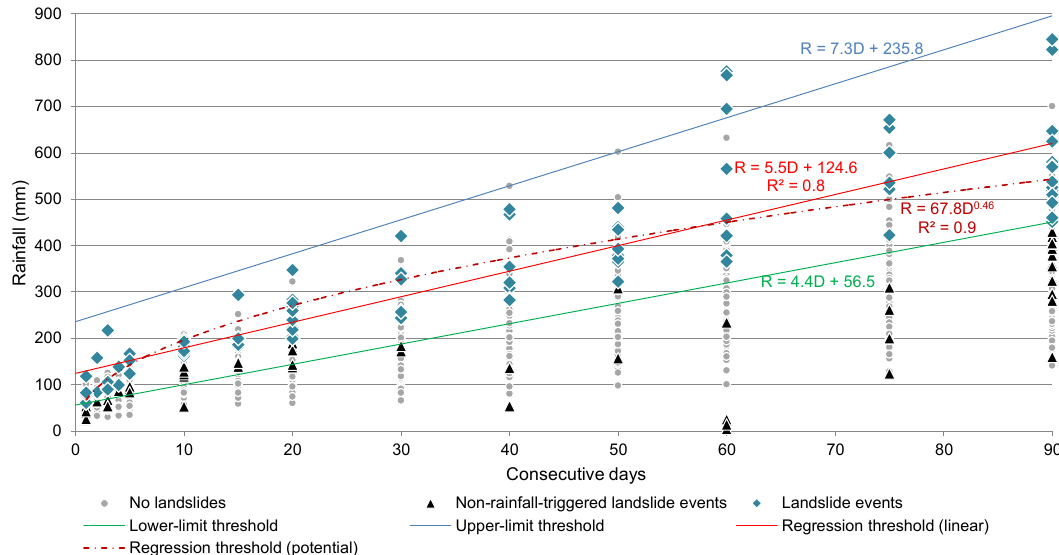
Figure 7. Cumulated rainfall duration thresholds for landslide events in the Lisbon region (1865 to 2010). Distance up to 10km from the reference rain gauge. Table 3. ROC metrics associated with rainfall thresholds and intermediate thresholds for landslide events in the Lisbon region.